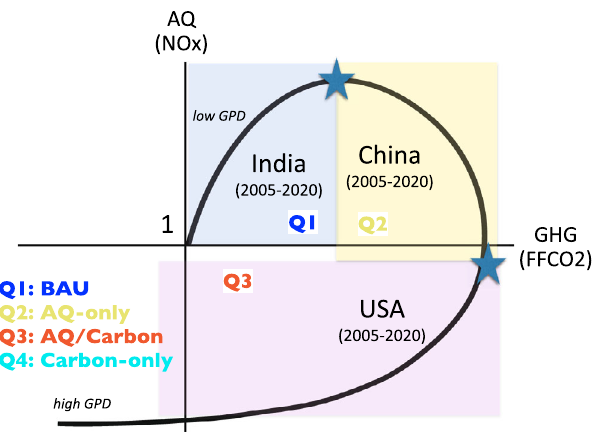
Fig. 1 | The schematic diagram of the modi fi ed environmental Kuznets curve (MEKC). The MEKC concept represents the relationship between greenhouse gas (GHG) emissions (x-axis) and air quality (AQ) emissions (y-axis) under developing economy. Q1is the business-as-usual (BAU) condition. Q2 isthe AQonly reduction phase. Q3 is the AQ and GHG co-reduction phase. Q4 is the Carbon-only reduction phase.